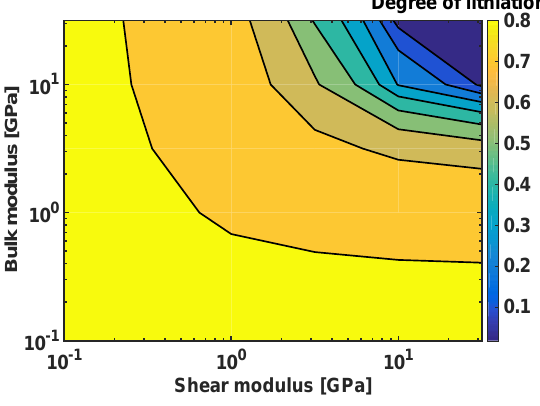
Figure 8: Degree of lithiation as a function of the bulk modulus and shear modulus; h=10 Figure 8. Degree of lithiation as a function of the bulk modulus and shear modulus; h = 10 nm .